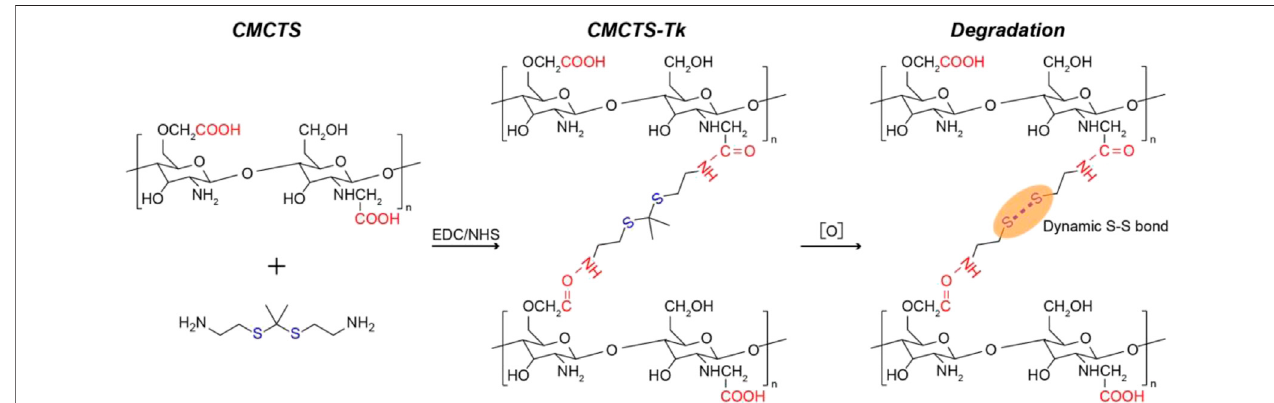
FIGURE 1 | Schematic representation of Cur@CMCTS hydrogel preparation and degradation procedures.